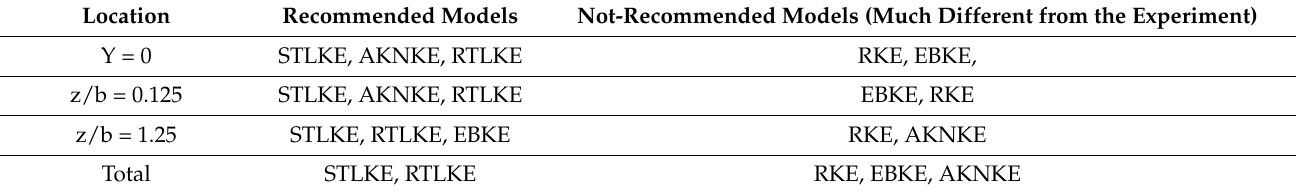
Table 15. Comparison of turbulent kinetic energy in low wind-speed area.